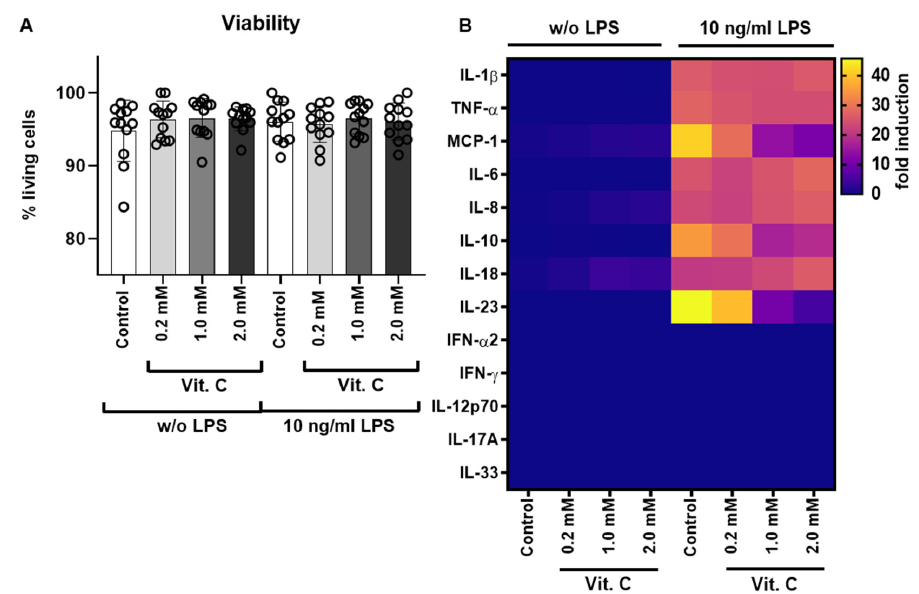
Figure 1. PBMC viability analysis and cytokine secretion analysis after vitamin C treatment. ( A ) The viability of the PBMCs was measured with the Countess TM II FL Automated Cell Counter and a trypan blue staining. An untreated control and three different vitamin C concentrations were examined, as well as an LPS-treated control and the three vitamin C concentrations under LPS (10 ng/mL) stimulation. Shown are the mean values in percent viability and the standard deviations, with one separate data point for each donor of isolated PBMCs in all 12 donors after 6 h of treatment with different vitamin C concentrations (0.2–2 mM). ( B ) Heat map analysis of the cytokine secretion detected with the LEGENDplex TM human inflammation panel 1 via flow cytometry, after stimulation of the cells with different vitamin C concentrations (0.2–2 mM) with (10 ng/mL) or without LPS; shown is the fold induction compared to the control w/o LPS. Additional data analysis stratified according to gender is available as Figure S2. IFN = interferon; IL = interleukin; LPS = bacterial lipopolysaccharides; MCP = monocyte chemo-attractant protein; PBMCs = peripheral blood mononuclear cells; TNF = tumor necrosis factor; Vit. C = vitamin C.